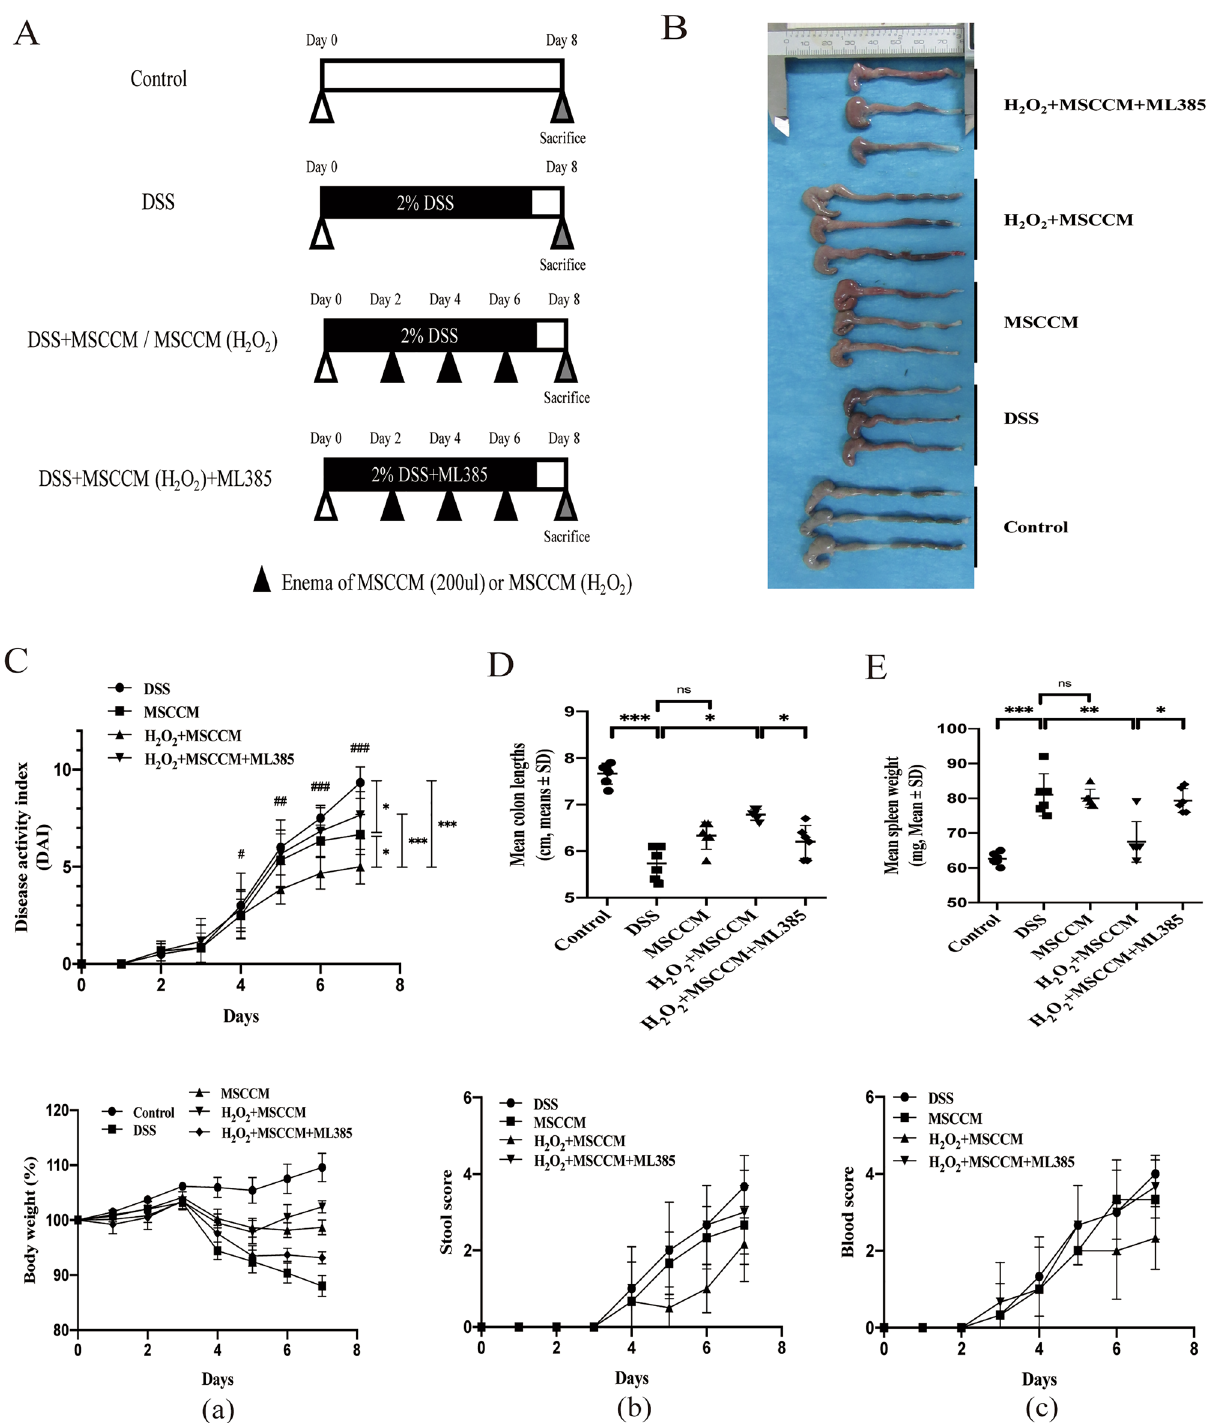
Figure 3. Therapeutic effects of H 2 O 2 pretreated MSC-CM in DSS-induced colitis mice. ( A ) Experimental protocol for DSS-colitis model. Mice received drinking water with 2% DSS for 7 days, and treatment groups were given an enema administration of vehicle control, 25 μM H 2 O 2 pretreated MSC-CM (200 µl), MSC-CM (200 µl), or ML385 (30 mg/kg). ( B ) Macroscopic images of representative colons at sacrifice. ( C ) Disease activity score is based on the loss of body weight (a), stool condition (b), and fecal occult blood (c) at sacrifice. ( D ) Disease-related shortening of the colon and quantified in a bar graph. ( E ) Disease-related lightening of the spleen and quantified in a bar graph. The data are expressed as the mean ± SD. n = 6 animals per group per time point. * P < 0.05, ** P < 0.01, and *** P < 0.001, significantly different between groups; ns = no significance. # P < 0.1, ## P < 0.01, ### P < 0.001, significantly different within